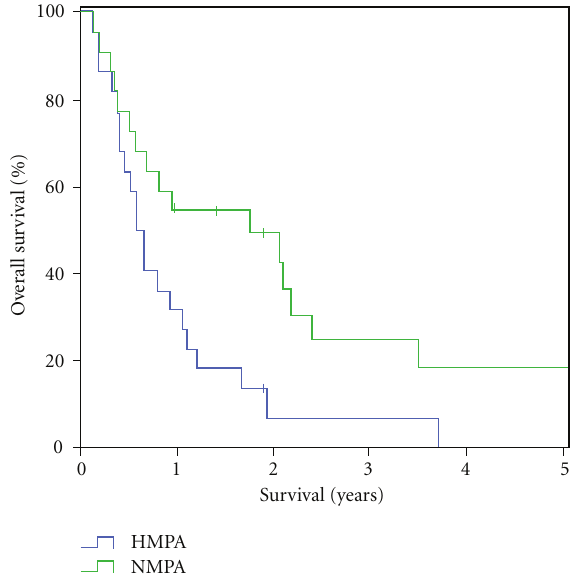
Figure 1: Patient overall survival: HMPA versus NMPA.